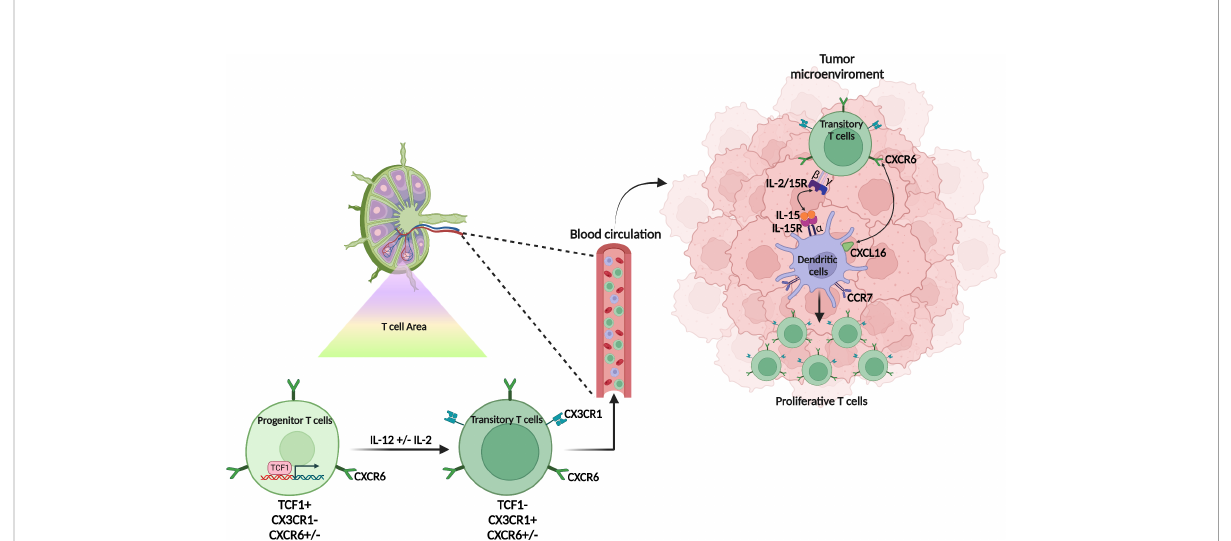
FIGURE 1 Origin and differentiation of CXCR6 + T cells. CXCR6 + T cells are scarcely present in the lymph node and CXCR6 weakly expressed by both the progenitor (TCF1 + ) or the transitory (TCF1 - , CX3CR1 + ) T cell population. In the tumor microenvironment, the transitory T cells express CXCR6 which allows them to interact with the dendritic cell subpopulation (CCR7 + DC3) which expresses the membrane form of CXCL16. This contact promotes the interaction of IL-15 also expressed on the membrane of DC3 with the bg chain of IL-15R expressed on CXCR6 + T cells. IL-15 induces the proliferation of CXCR6 + T cells and promotes their survival in the tumor